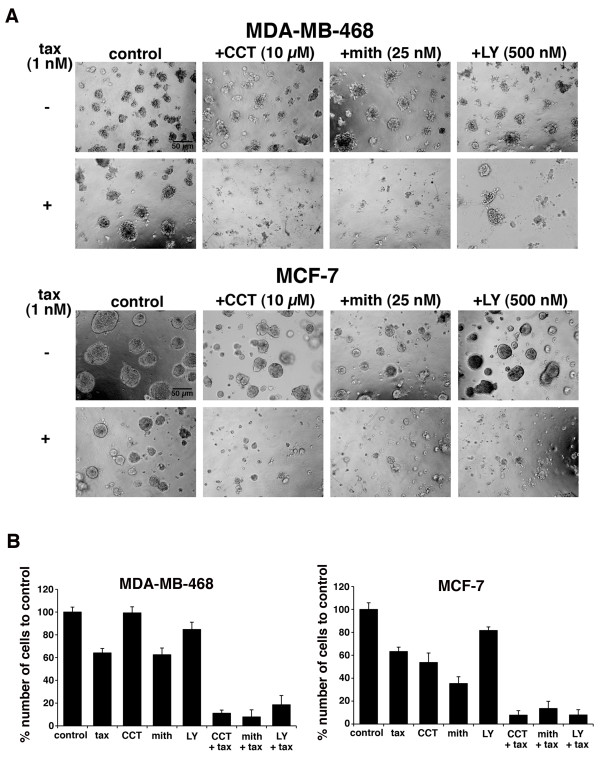
Analysis of drug combinations on growth of breast cancer cells grown in 3D cultures. A. Cells were seeded on Matrigel in eight-well chamber slides as described in Materials and Methods. 3D cultures formed after two days and were treated every two to three days with single agents, vehicle (control), 1 nM paclitaxel (tax), 500 nM LY2109761 (LY), 10 μM CCT007093 (CCT), 25 nM mithramycin (mith) (upper panels) or a combination of drugs (lower panels). After 10 to 14 days, mammospheres were visualized using phase-contrast microscopy. Bar scale, 50 μm. B. To count cell numbers, the Matrigel was dissolved, mammospheres were collected, trypsinized and single cells were counted by trypan blue exclusion assay using a hemocytometer. The percent cell number relative to control was plotted for each drug or combination for the two cell lines. Error bars represent standard deviation from replicates from three independent experiments.